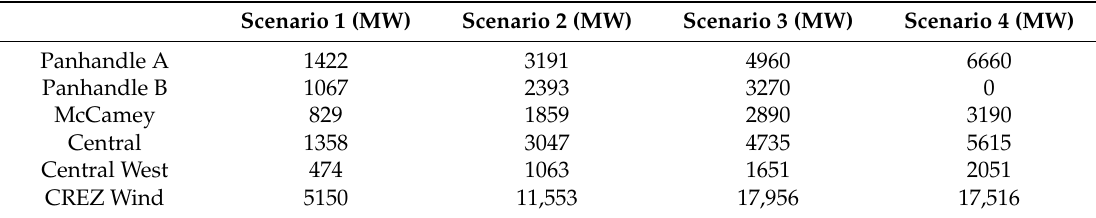
Table 3. MW tiers proposed by the Electric Reliability Council of Texas (ERCOT) for competitive renewable energy zones (CREZs) in a transmission optimization study